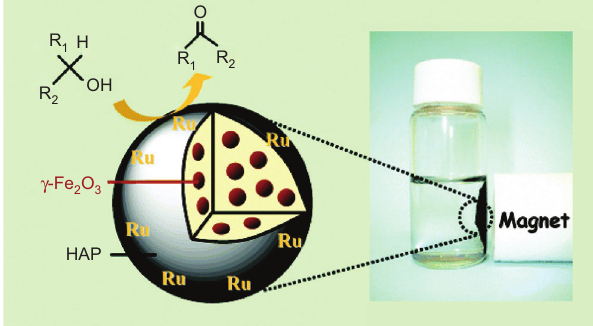
O from the reaction mixture 2 3